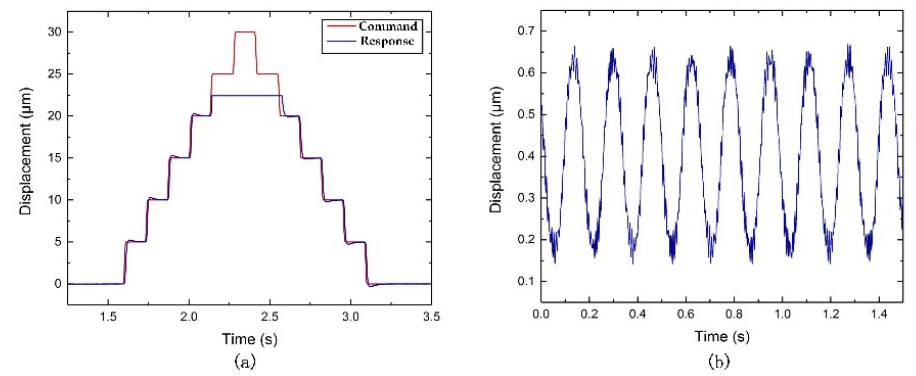
Figure 16. Experimental results of ( a ) motion stroke of the x-axis, ( b ) the coupling motion along the z-axis.